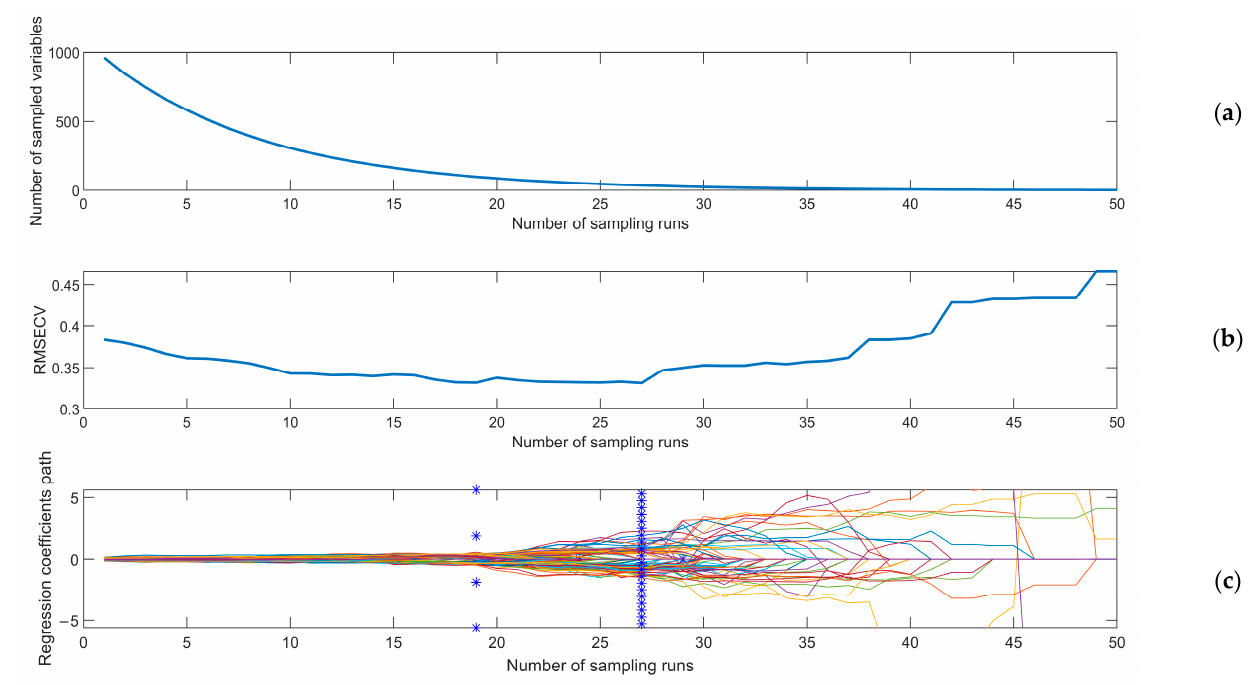
Figure 7. The CARS process. Numbers of selected wavelengths ( a ), RMSECV ( b ) and regression coefficient paths ( c ).